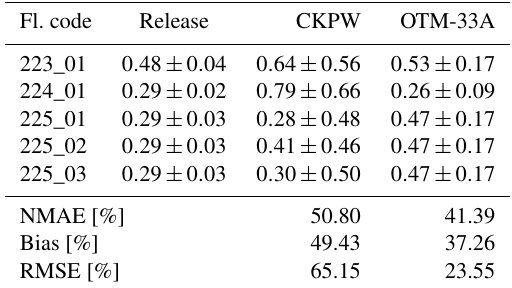
Table 4. Emission rates from QCL-CKPW and OTM-33A in gs − 1 . Fl.